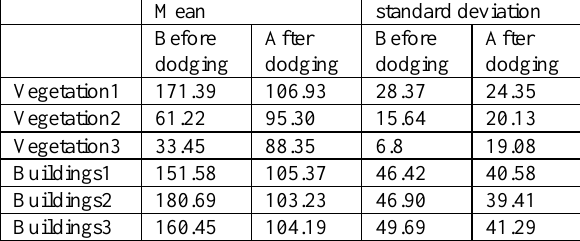
Table 1. The image information before and after